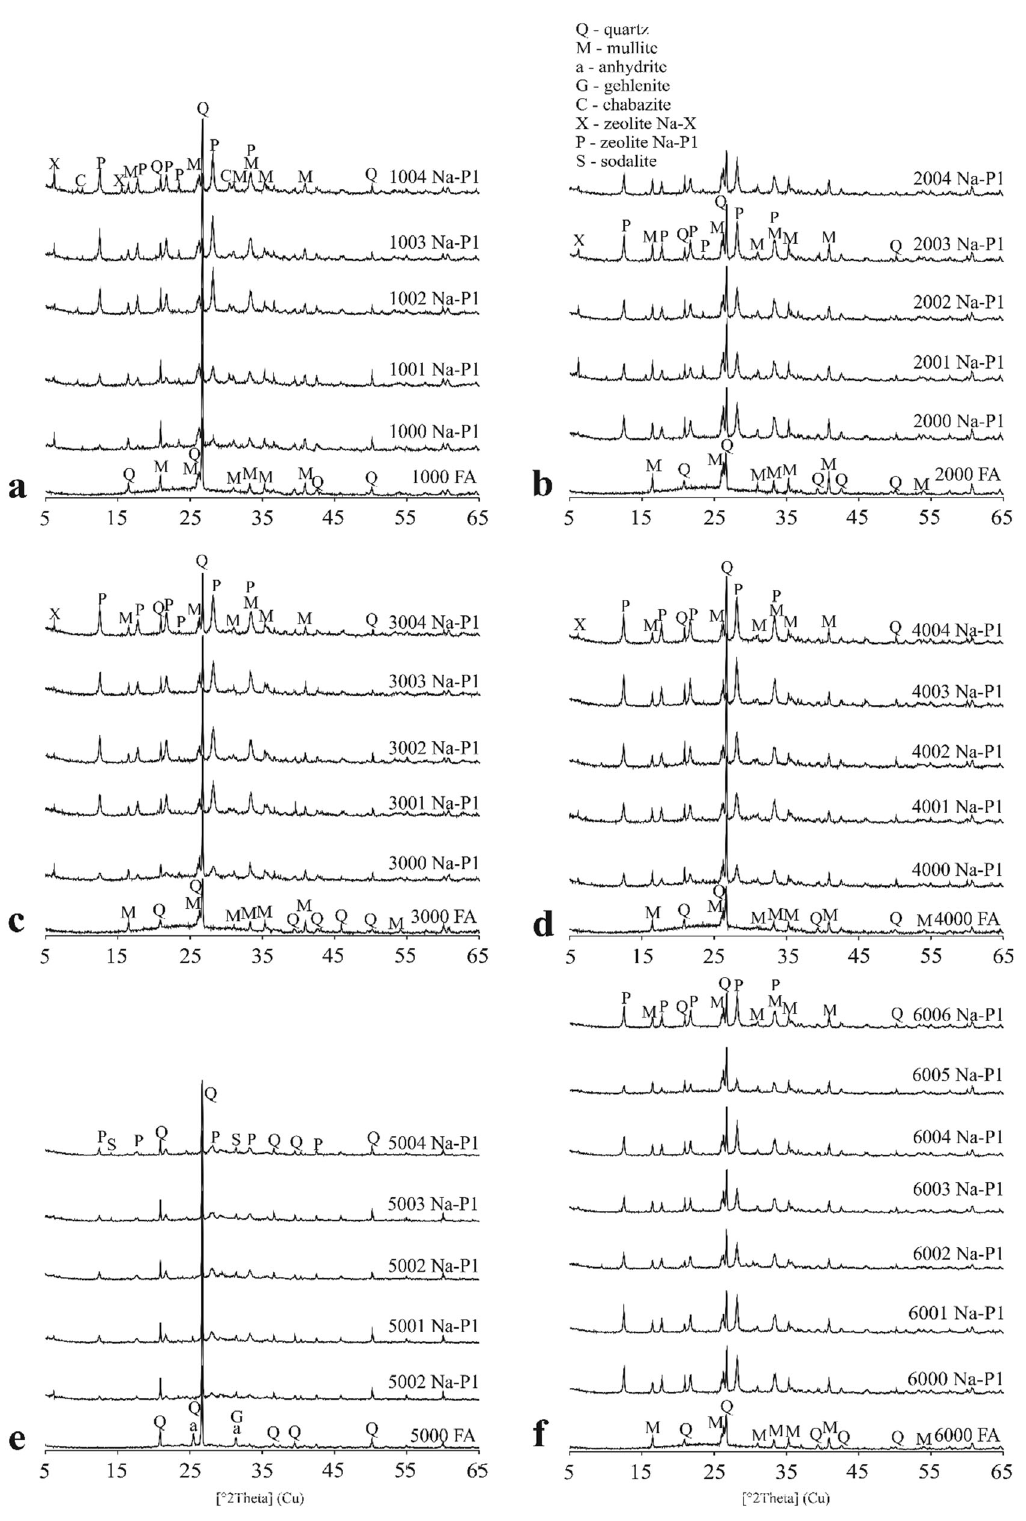
Fig. 4 XRD analyses of raw fly ashes and attempts of Na-P1